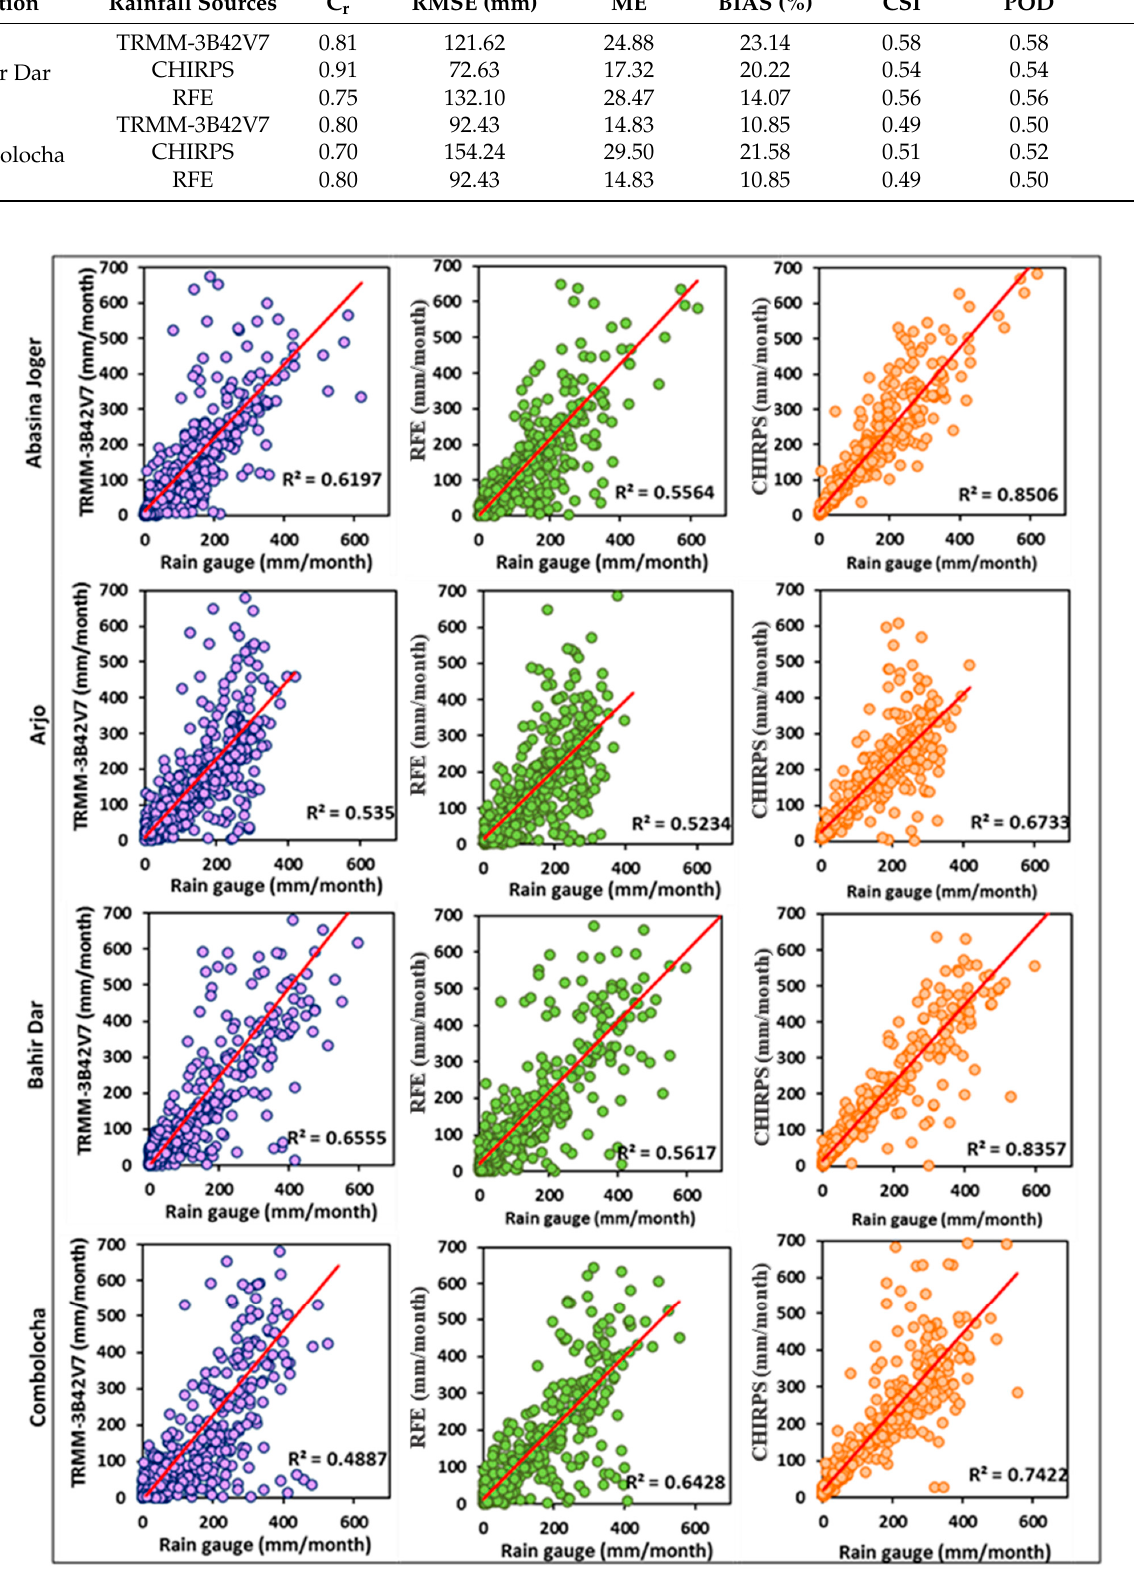
Figure 6. Scatter plots of the satellite products and gauge